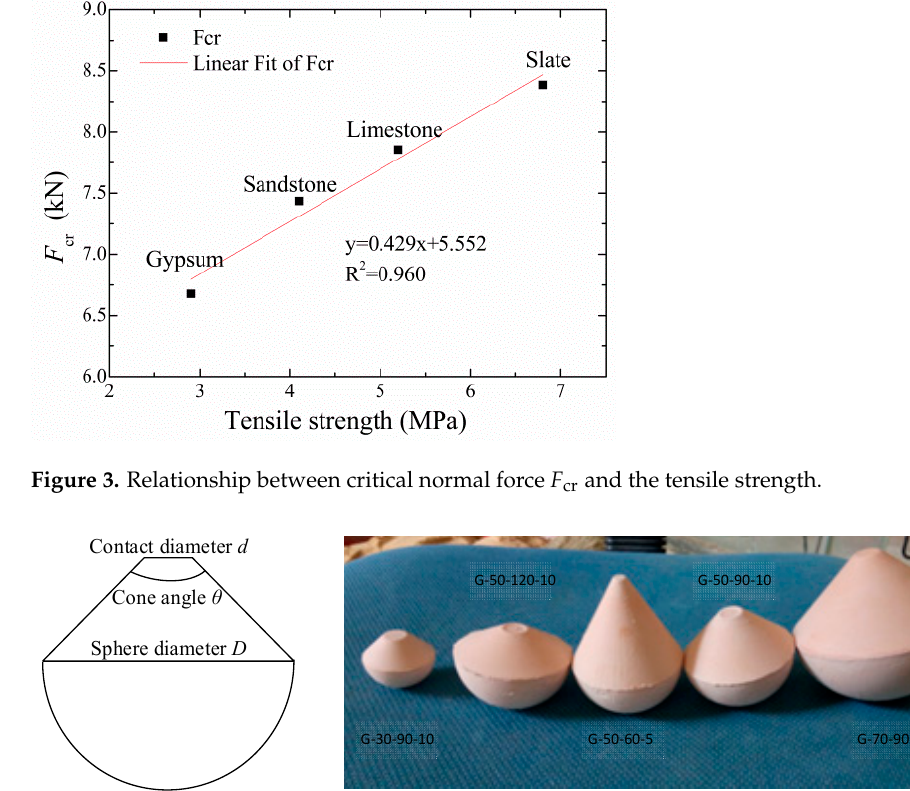
Figure 4. Cone–hemispherical particle.